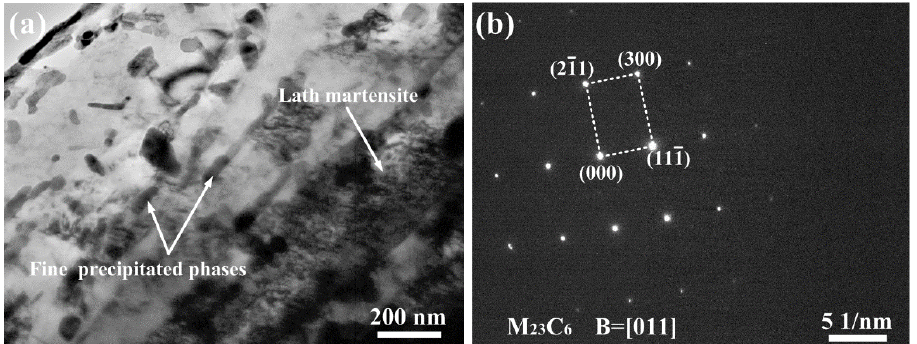
Figure 12. TEM analysis of BM-2. ( a ) Bright-field image. ( b ) Carbide in ( a ) analyzed by SAEDP.